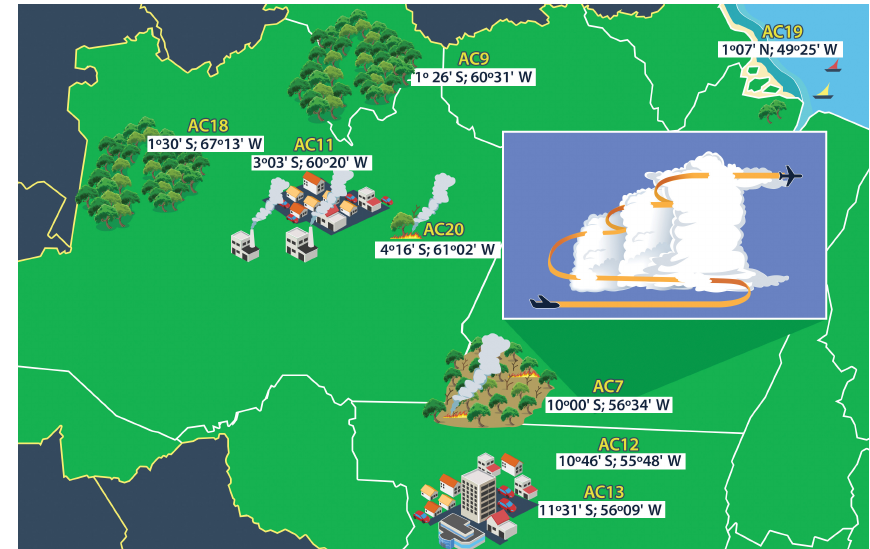
Figure 1. Locations where cloud profiles have been collected for different HALO flights. Clouds formed over southern Amazonia and in the Manaus region are subject to higher aerosol loadings due to the presence of the deforestation arc and urban emissions. Clouds formed over the northern and northwestern Amazon are driven by background conditions with low aerosol concentration. During the GoAmazon2014/5 IOP2, maritime clouds were also profiled on the Atlantic